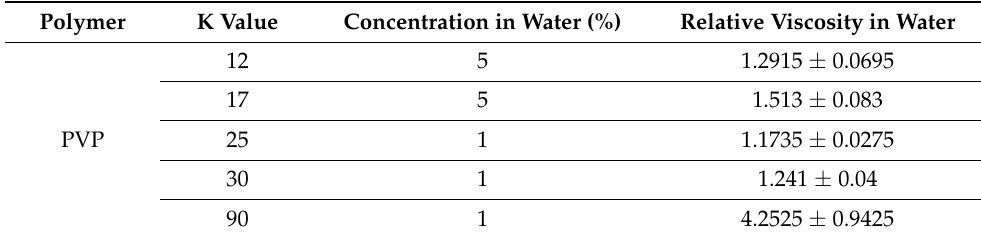
Table 2. Viscosity range of different grades of PVP concentrated in water [9]. Polymer K